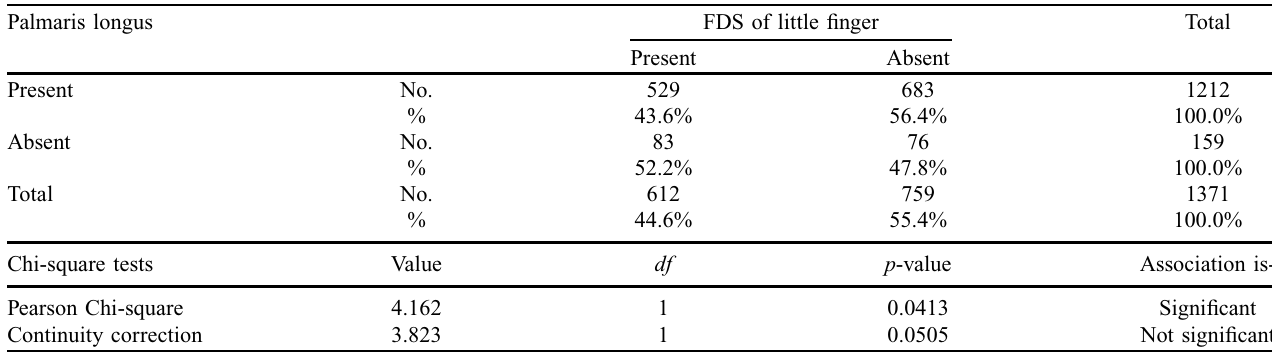
Significant association between palmaris longus and flexor digitorum superficialis* of the little finger when considered bilaterally. p -value = .0413